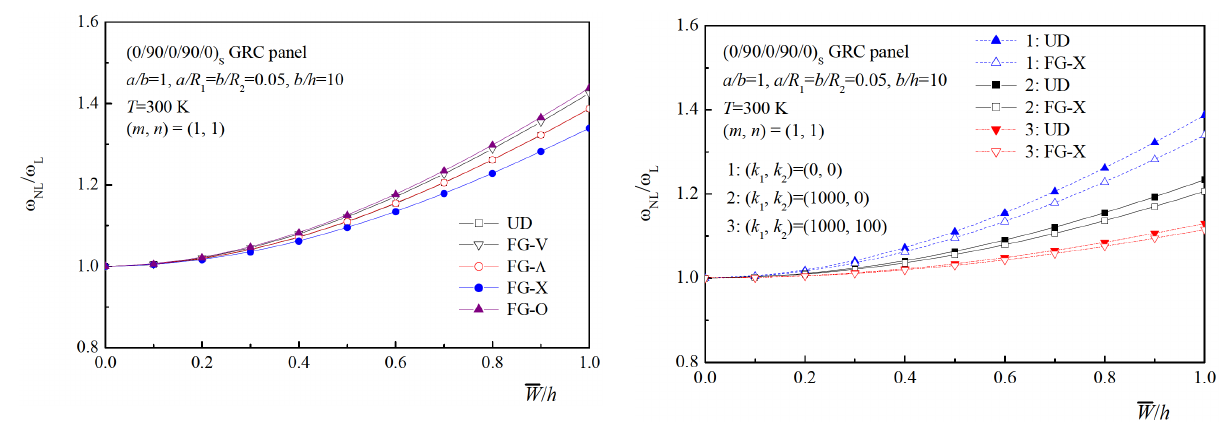
Figure 6: Influence of foundation stiffness on the frequency- amplitude curves of doubly curved (0/90/0/90/0) S GRC laminated panels resting on elastic foundations